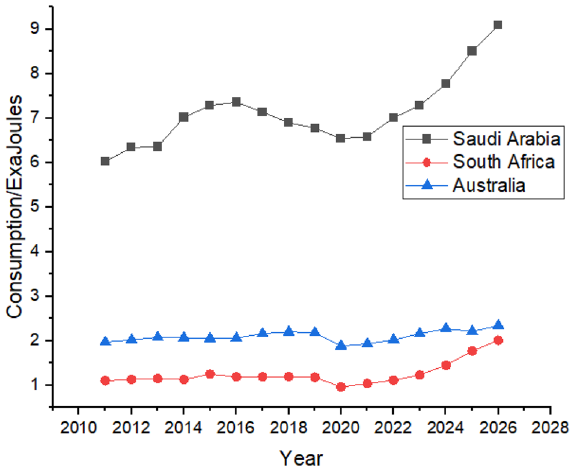
Figure 6. Oil consumption in Australian, African and Middle Eastern Countries.